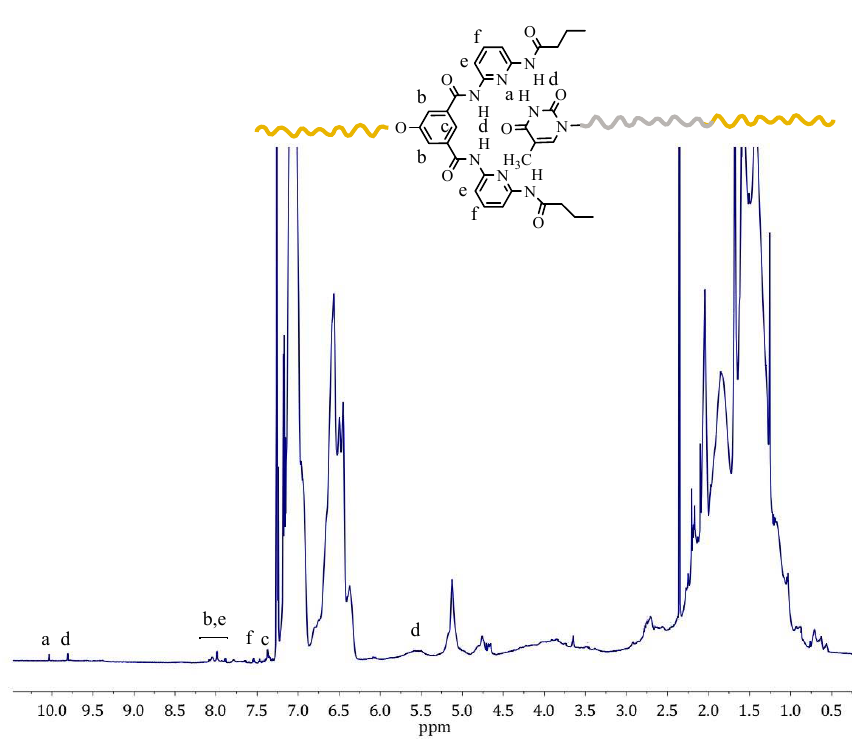
Figure 7. 1 H-NMR spectrum of sample Blend Figure 7. 1 H ‐ NMR spectrum of sample Blend #2. Figure 7. 1 H ‐ NMR spectrum of sample Blend #2.